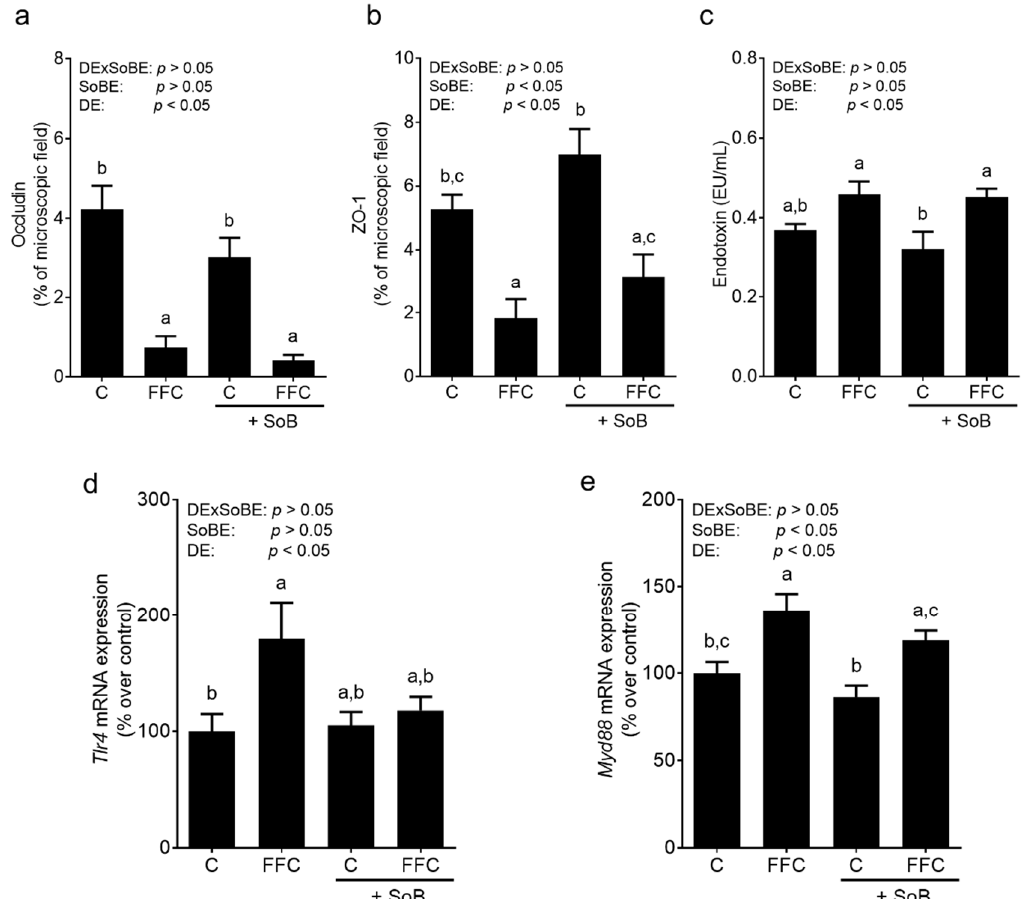
Figure 5. Effect of supplementation of SoB on tight junction proteins in upper parts of the small intestine, bacterial endotoxin levels and on markers of the toll-like receptor 4 (Tlr4) signaling cascade of mice with FFC-induced NASH. Qualitative analysis of ( a ) occludin, ( b ) ZO-1 protein staining in proximal small intestine, ( c ) bacterial endotoxin concentration in portal plasma as well as expression of ( d ) Tlr4 and ( e ) myeloid differentiation primary response gene 88 ( Myd88 ) mRNA in liver tissue. Data are expressed as means ± SEM, n = 6-8. Data with different letters are significantly different, p < 0.05. C, control diet; DE, diet effect; DExSoBE, interaction between diet and SoB; FFC, fat-, fructose-, and cholesterol-rich diet; NASH, non-alcoholic steatohepatitis; SoB, sodium butyrate; SoBE; sodium butyrate effect, ZO-1, zona occludens 1.